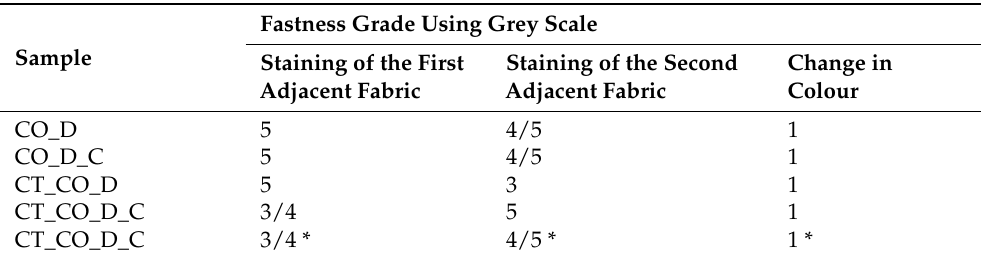
Table 5. Colour fastness to commercial and domestic washing using methods A1S and A1M* (* method A1M was performed only on sample CT_CO_D_C).